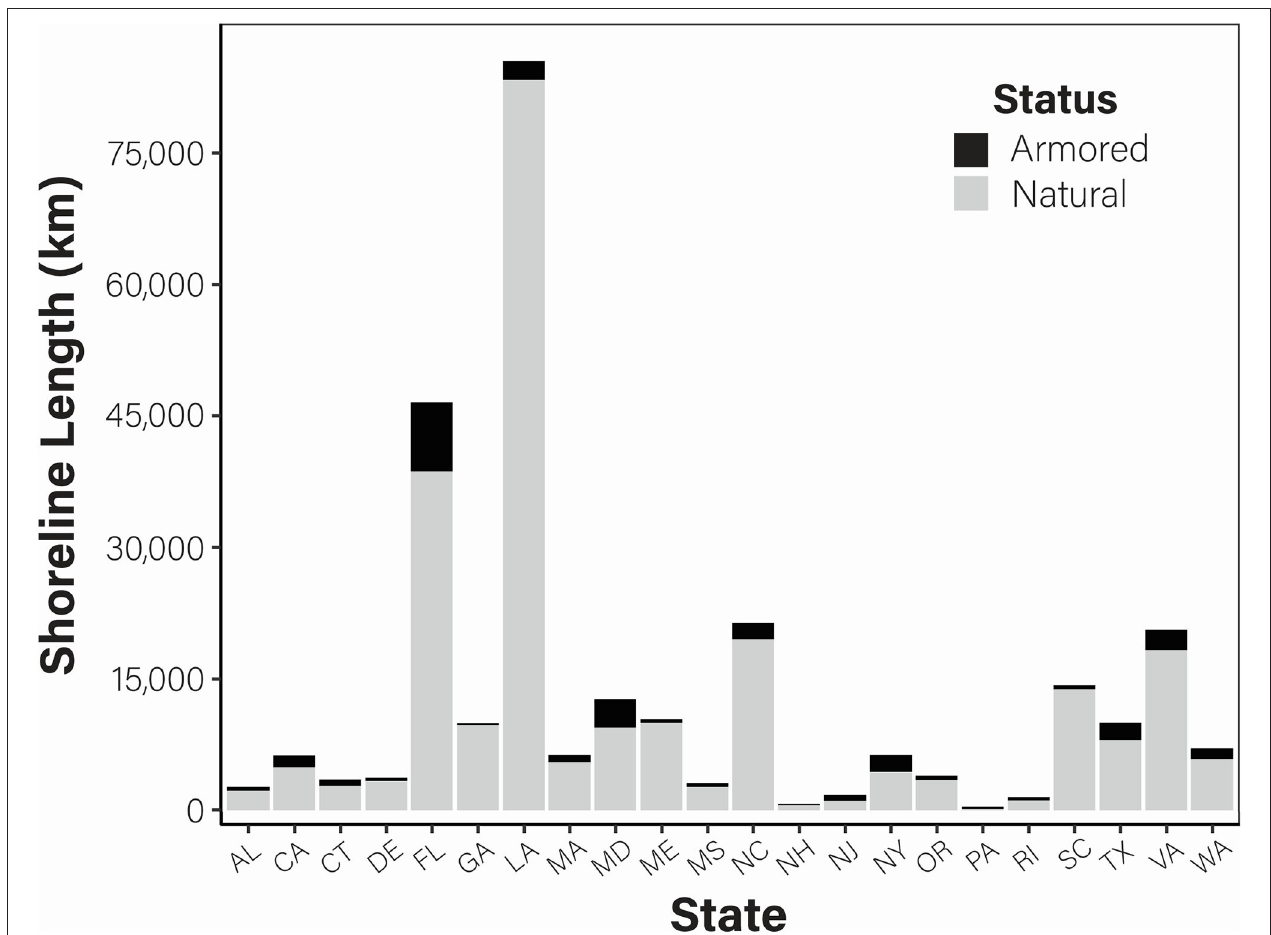
FIGURE 2 | Total length of natural (gray) and armored (black) shoreline in each U.S. coastal state. Note that direct comparisons of shoreline estimates across states are limited because the most recent update year and methodologies for mapping the shoreline varies from state to state. These data represent the best available national estimate of shoreline hardening in the United